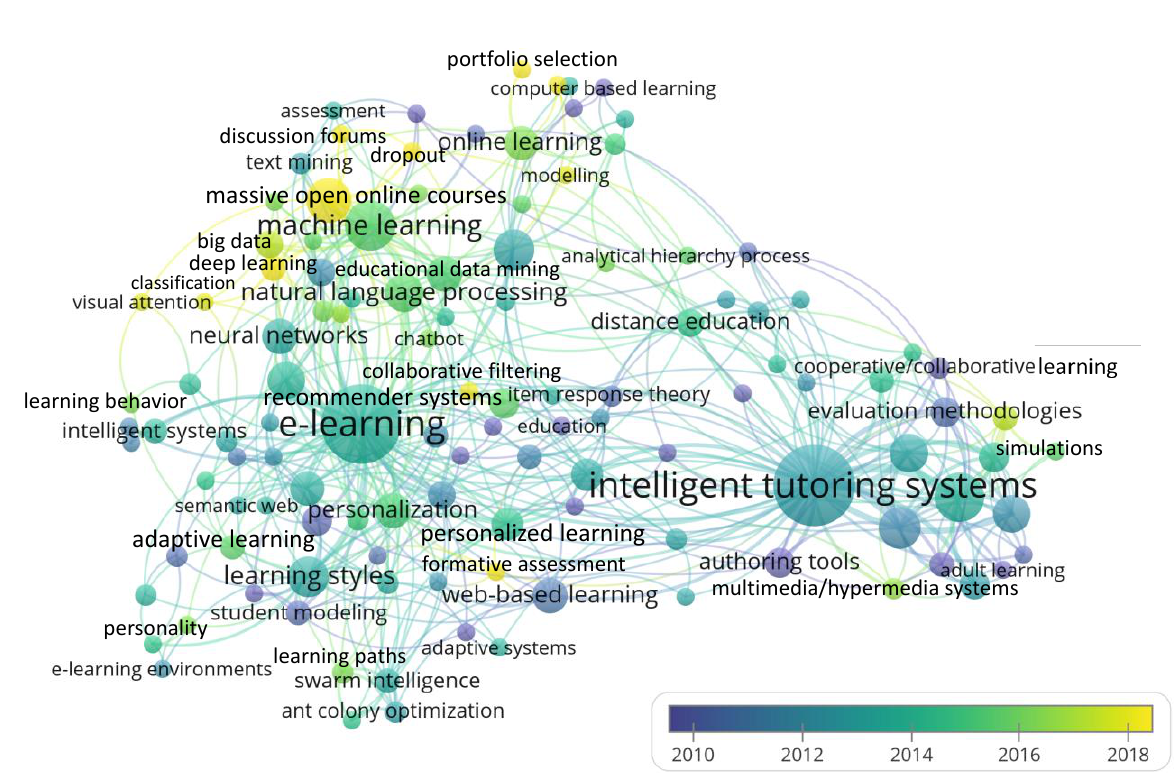
Network Map of Keyword Co-Occurrence on AIoL Research Over